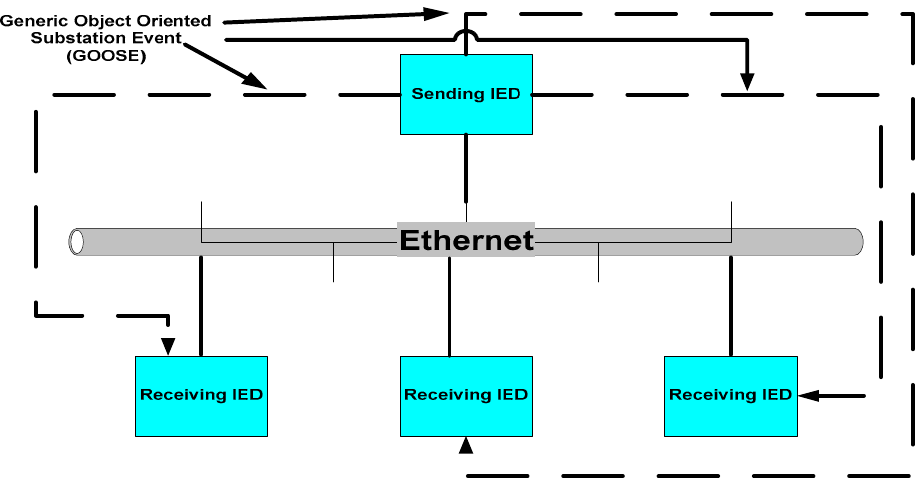
Figure 3. GOOSE communications between lEDs.